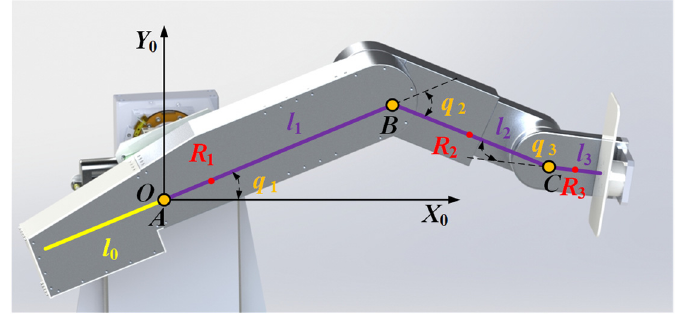
Figure 4. Mechanism model of the mechanical leg. Establish a global coordinate system { O - X 0 Y 0 Z 0 } at the hip joint rotation center point A . B and C represent the rotation centers of the knee and ankle joints respectively. q 1 , q 2 and q 3 are the joint variables of the three rotating joints, l 1 , l 2 and l 3 respectively represent the distance between the rotating joints, l 0 represents the distance between the counter- weight mess center and the hip rotating joint; R 1 , R 2 and R 3 represent the distance between the link mass center and the rotation center, respectively. The kinematic model of LLR-II is the same as the standard 3R mechanism, and its kinematics forward and inverse solu- tions can be calculated by the D-H method and geometric method. The results are shown in Equations (1) and (2) below :